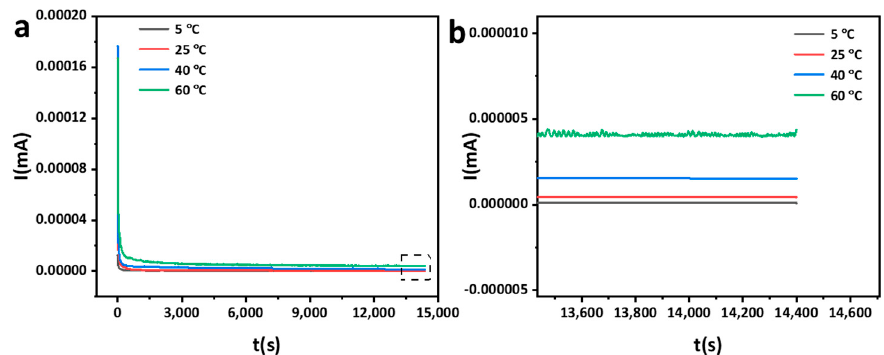
Figure 7. Potentiostatic polarization curves of AlCoCrFeNi 2.1 in chloride-containing sulfuric acid solution at different temperatures, ( a ) complete image; ( b ) enlarged image.